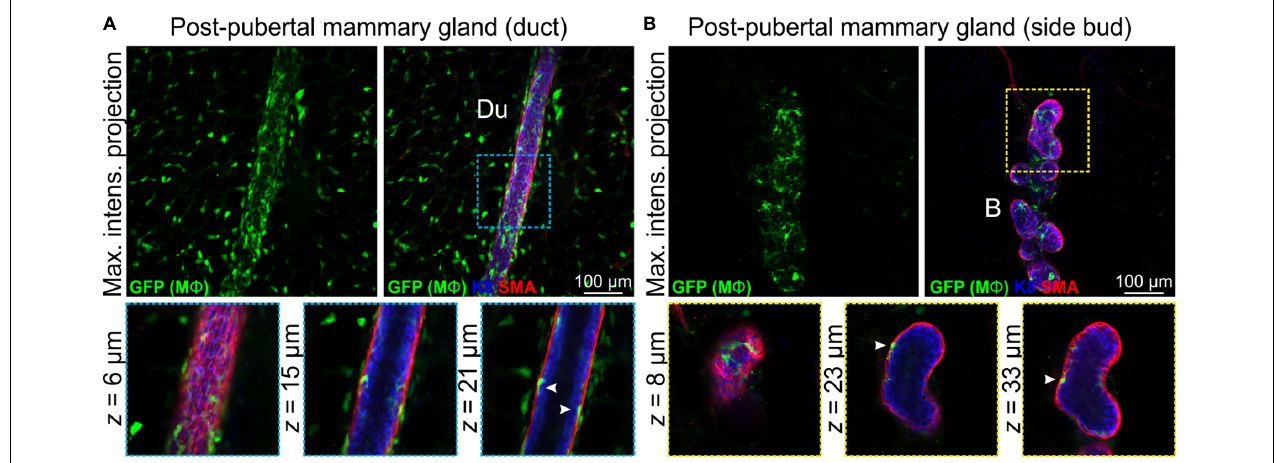
FIGURE 3 | M φ s in the mammary glands of post-pubertal virgin mice. Maximum intensity z -projection and single optical ( z ) slices of cleared mammary tissue from post-pubertal (12 week-old) Csf1r-EGFP mice. K8 immunostaining shows luminal cells; SMA immunostaining reveals basal cells and SMA-positive vessels. (A) Mammary ducts and (B) side buds. Du, duct; B, side bud. Arrowheads show M φ s that are positioned within the epithelial bilayer. K8 immunostaining reveals the luminal cell layer and SMA marks the basal cell layer. Images are representative of 3 mice.